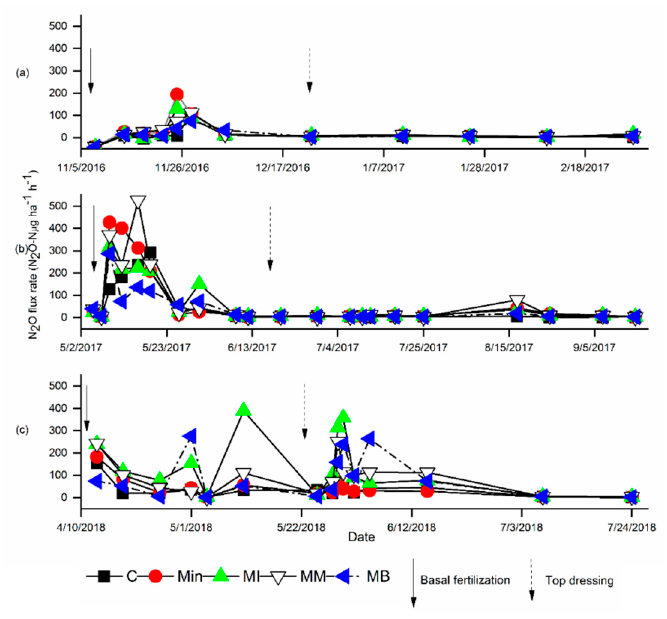
Figure 8. N 2 O (N 2 O-N µ g ha − 1 h − 1 ) flux rate from maize plots with different nitrogen (N) fertilizer treatments and a no N control (C) forcrop growing season 1 ( a ), season 2 ( b ) and, season 3 ( c ). Continuous line arrows indicate basal fertilizer application while dashed line arrows indicate top.